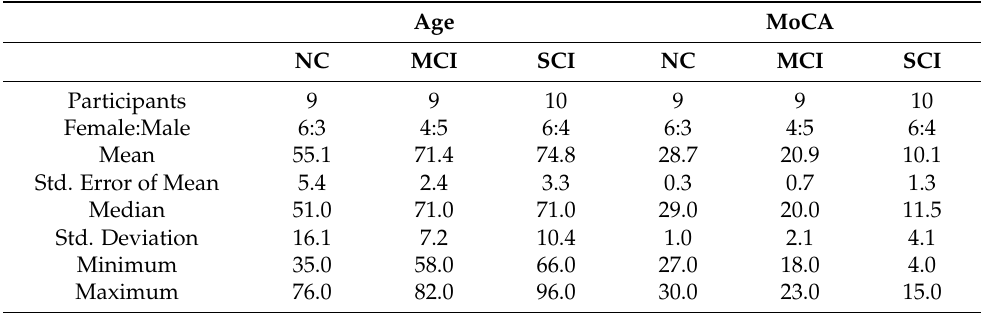
Table 1. Demographic data and MoCA scores in participant groups (NC—normal cognition, MCI— mild cognitive impairment, SCI—moderate and severe cognitive